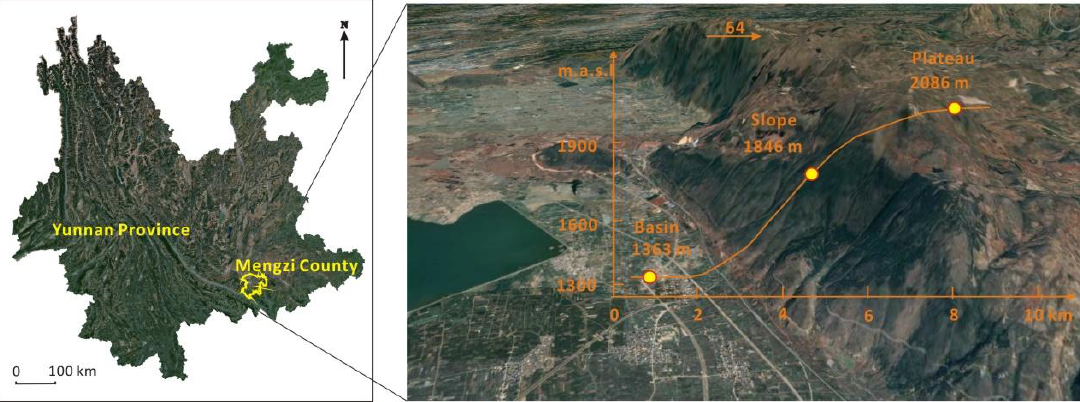
Figure 1. The location of the study